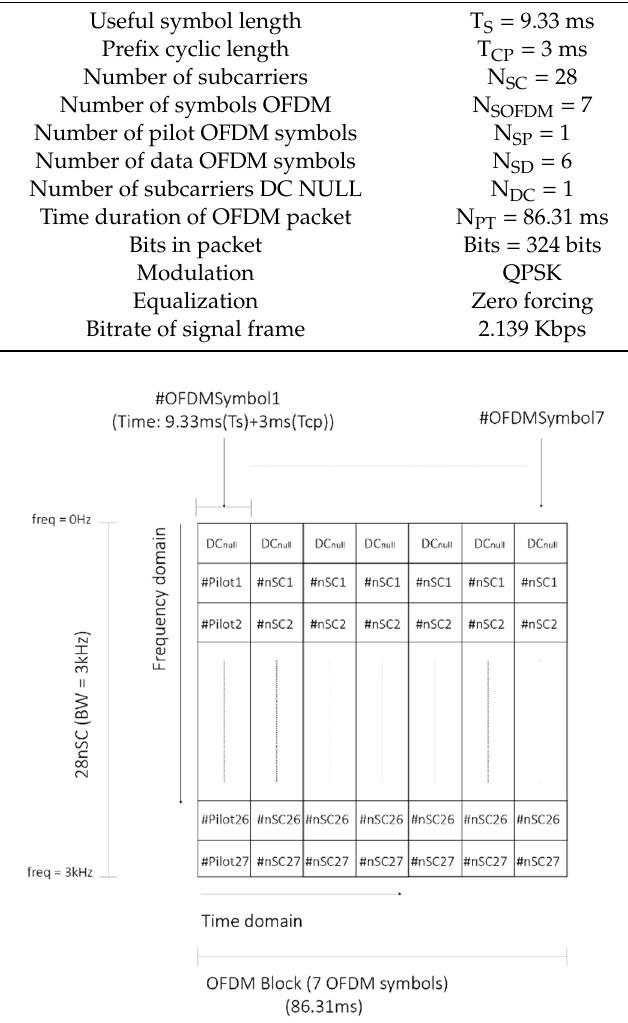
Figure 16. OFDM matrix configuration for NVIS transmission.